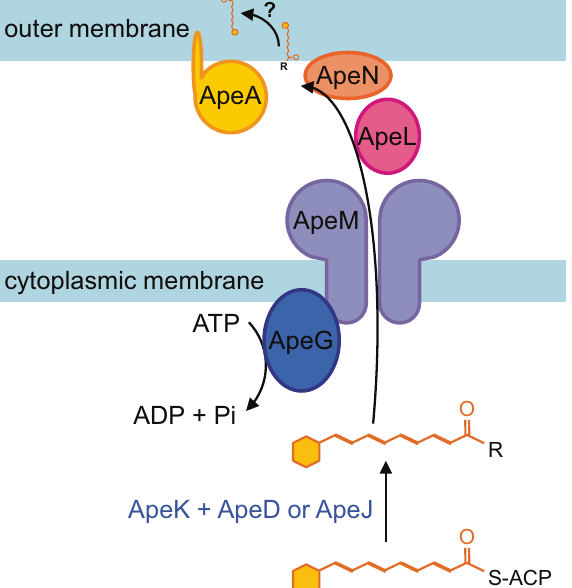
Fig. 8 Schematic diagram for APE export and outer membrane localization. Following biosynthesis of the core APE Ec -carboxylic acid (Fig. 3), we propose that this entity is attached to a larger lipid anchor molecule (R) by ApeD (lysophospholipid acyltransferase) and ApeJ (a glycosyltransferase/acyltransferase). This attachment process might be assisted by the ApeK thioesterase-mediated release of APE Ec from its ACP. The APE Ec -lipid might be transported across the cytoplasmic membrane by ApeM (an RND family transporter). The energy for this translocation could be provided by ATP hydrolysis catalyzed by ApeG (a predicted membrane-associated protein with a COG4648 pyrophosphatase domain). Since ApeL and ApeN share weak homology to components of the ‘ localization of lipoprotein ’ (Lol) pathway and ApeA encodes for a lipoprotein, these proteins could be involved in localization of the APE Ec -lipid to the outer membrane. Finally, the APE Ec containing anchor lipid is potentially fl ipped to the outer lea fl et of the outer